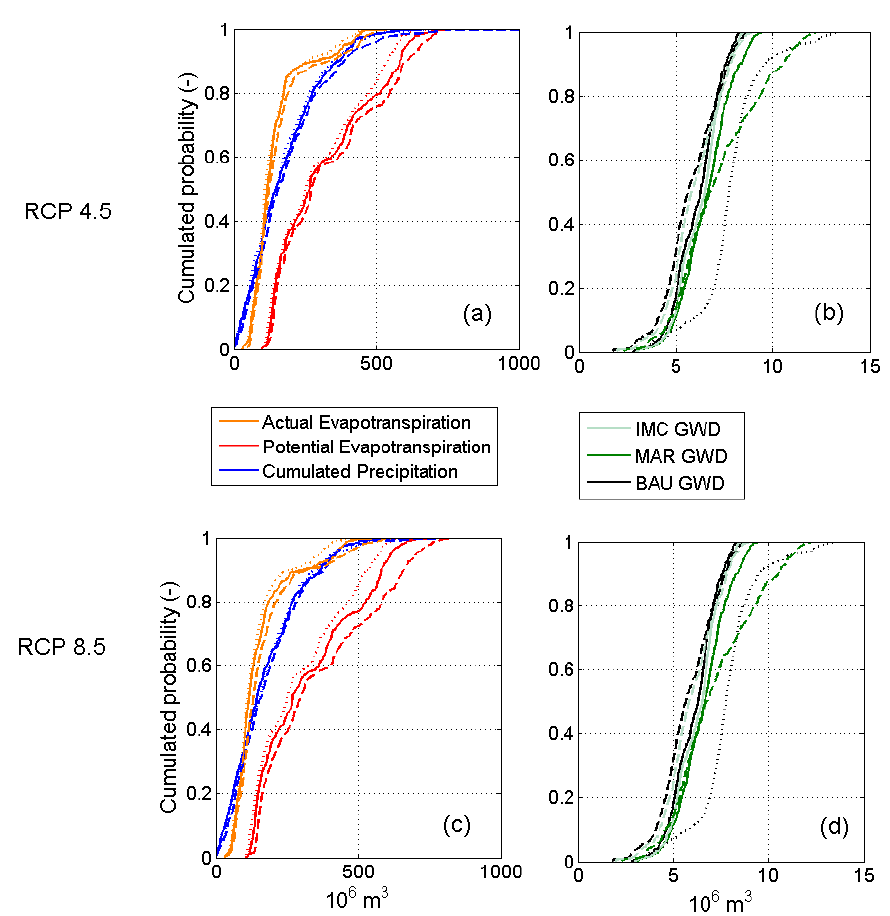
Figure 9. Panel ( a ): cumulated density function of monthly cumulated precipitation, potential and actual evapotranspiration of the RCP 4.5 simulations for the periods 1981–2020 (dot lines), 2021–2060 (full lines) and 2061–2100 (dash lines). Panel ( b ): cumulated density function of natural groundwater discharge (GWD) (same layout of panel a). Panels ( c ): results of RCP 8.5 simulations (same layout of panel a ). Panels ( d ): results of RCP 8.5 simulations (same layout of panel b ).